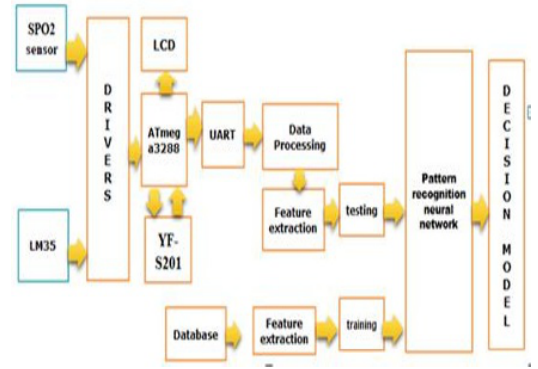
Fig 1. Block diagram of the device